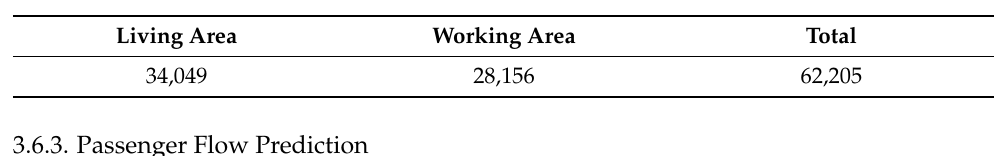
Table 4. Statistics of working/living area dataset.